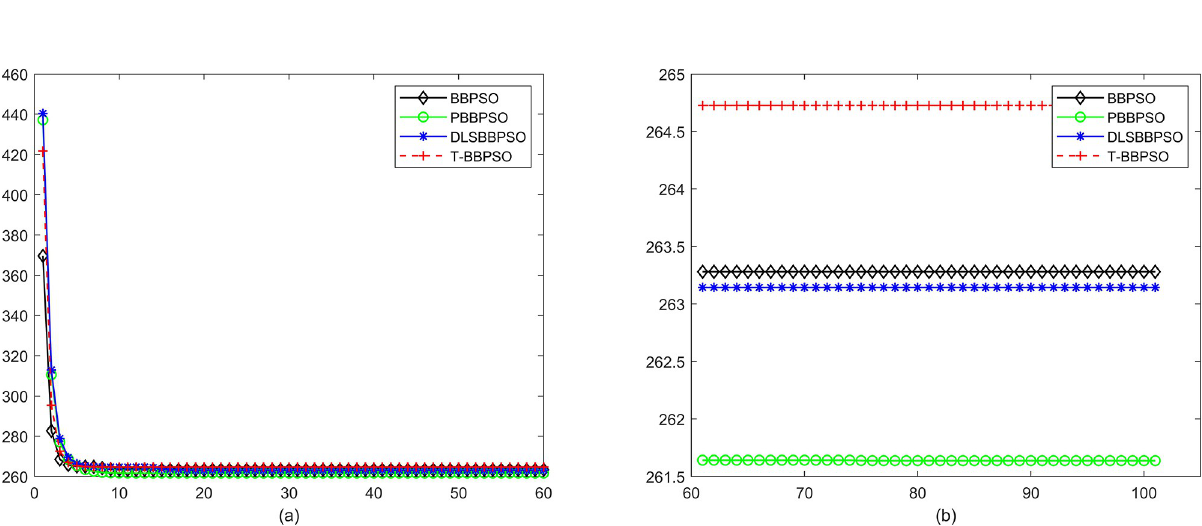
Fig 26. Comparison of convergence speed between BBPSO, PBBPSO, DLS-BBPSO and TBBPSO, f 24 , (a) iteration 0–6000, (b) iteration 6000–10000 the unit is 100 iteration.